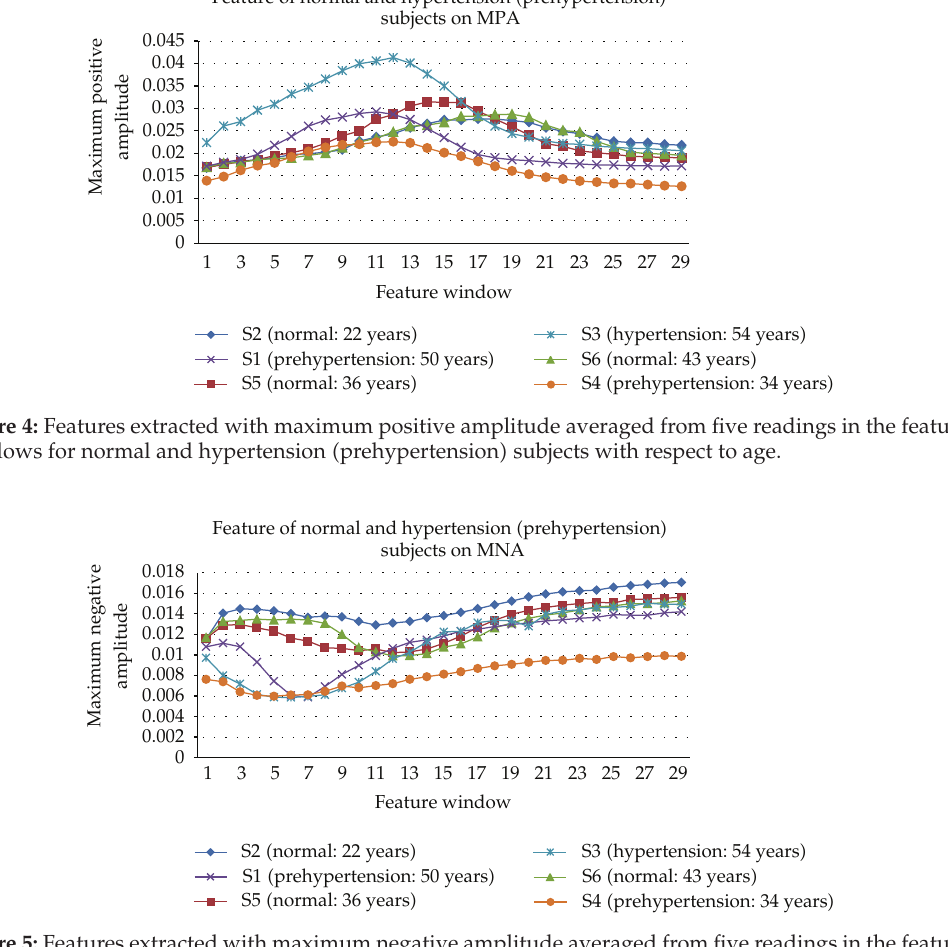
Figure 5: Features extracted with maximum negative amplitude averaged from five readings in the feature windows for normal and hypertension (cid:3) prehypertension (cid:4) subjects with respect to